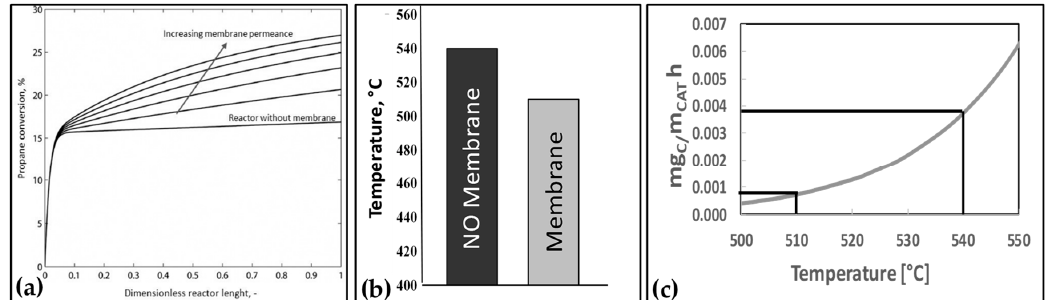
Figure 8. Performance of membrane-based propane dehydrogenation: ( a ) numerical simulation of propane conversion at T = 550 °C and different membrane permeances 40–80 Nm 3 /hm 2 bar 0.5 , ( b ) experimental operating temperature at fixed propane conversion (X C3H8 = 10%, 5 barg, S/C3 = 0.25), ( c ) coke amount as a function of the operating temperature.